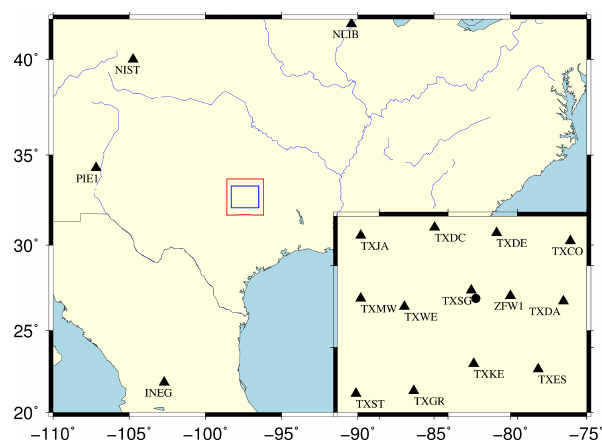
Figure 2. Geographical distribution of CORS stations (black trian- gles) selected in the tomography area which corresponds to the blue rectangle and the radiosonde station (black circle). The blue rect- angle is the original area, while the red rectangle is the auxiliary